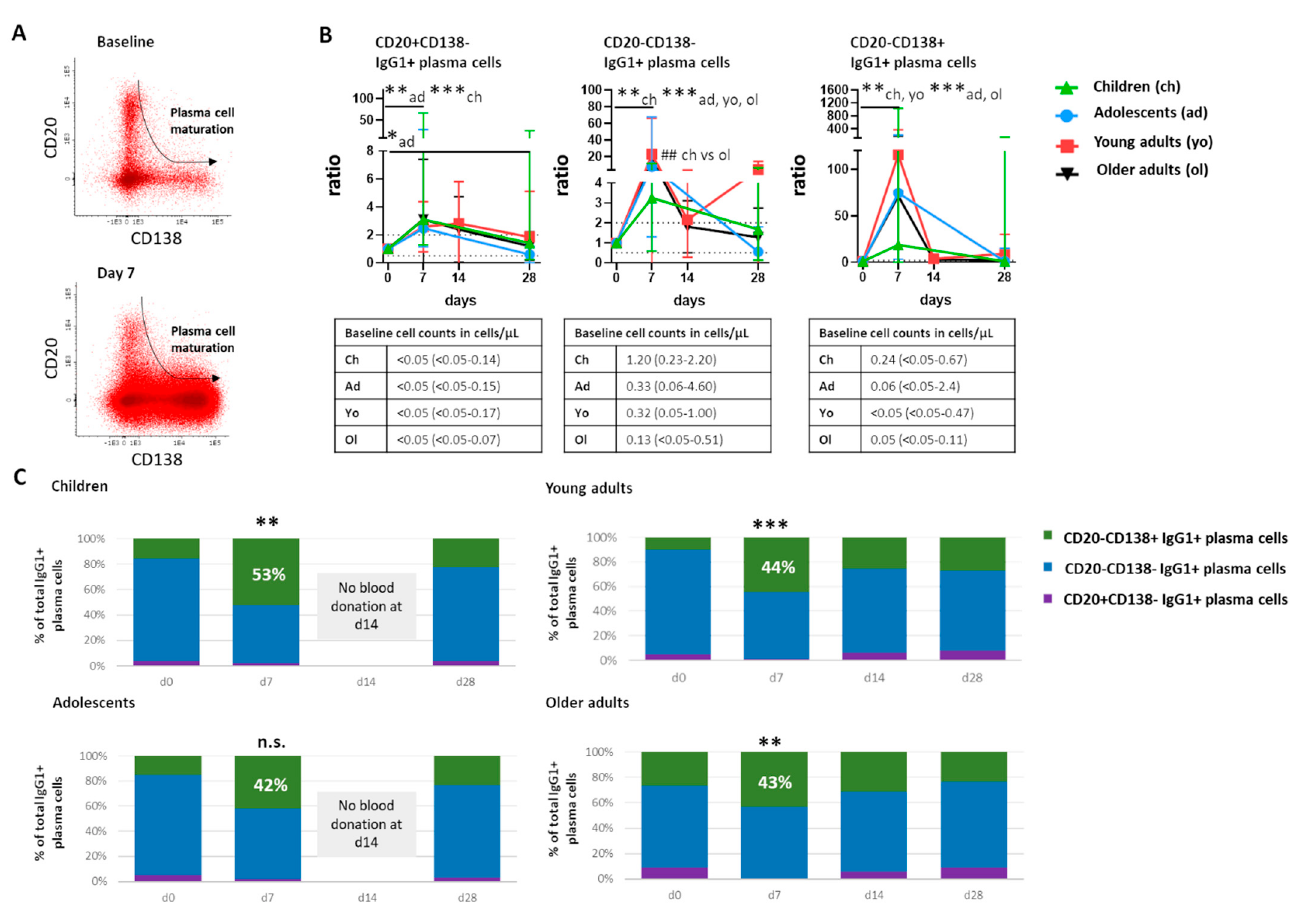
Figure 3. Over-time maturation of IgG1+ plasma cells. ( A ) Representative dot plots showing the phenotypical changes during plasma cell maturation. The top plot shows a baseline situation and the bottom plot shows a situation at day 7 postvaccination. Each dot represents an individual cell. The arrow indicates the direction of changes during maturation. ( B ) Over-time quantitative changes in IgG1+ plasma cells belonging to different maturation stages, presented as ratio over baseline (median, min-max). Dashed lines indicate a ratio over baseline of 0.5 and 2. Underneath each graph, a table shows the baseline cell counts of that population in cells/ µ L (median, min-max). ( C ) Over-time distribution of IgG1+ plasma cells representing different maturation stages with total IgG1+ plasma cells based on expression of CD20 and CD138. Median values for each population were used to construct the plots. Wilcoxon matched pair signed-rank test followed by Bonferroni correction was used to assess longitudinal differences in percentage of CD20-CD138+ cells in total IgG1+ plasma cells within each cohort. Differences in the percentage of CD20-CD138+ cells in total IgG1+ plasma cells between cohorts were assessed using Kruskal – Wallis followed by Dunn’s test but did not yield significant differences. For pediatric cohorts, no blood samples were collected at day 14; the Mann – Whitney test followed by Bonferroni correction was used. For longitudinal changes, only significant differences compared with baseline are shown. Significant longitudinal differences within a cohort are indicated as *, p < 0.05; **, p ≤ 0.01; ***, p ≤ 0.001. Significant differences between cohorts at the same time point are indicated as ##, p ≤ 0.01. d = days after vaccination.